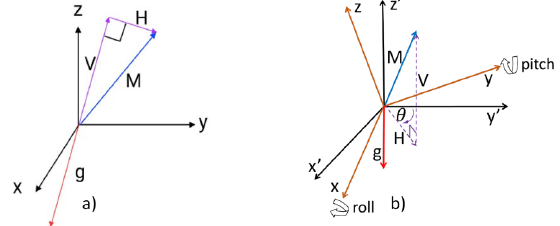
Figure 2. The illustration of vector projection (a) and horizontal component transformation (b)